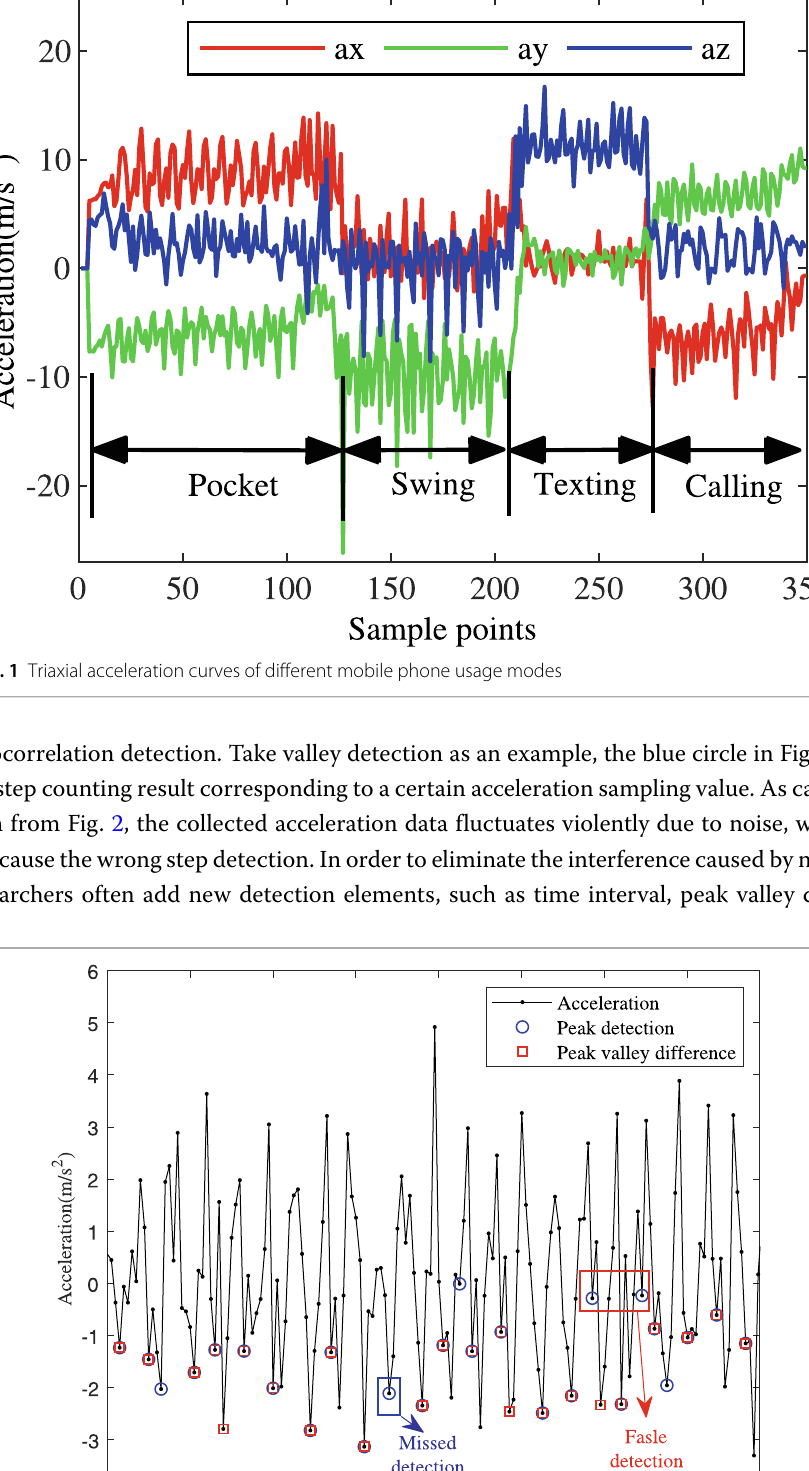
Fig. 2 False detection and missed detection in different step counting